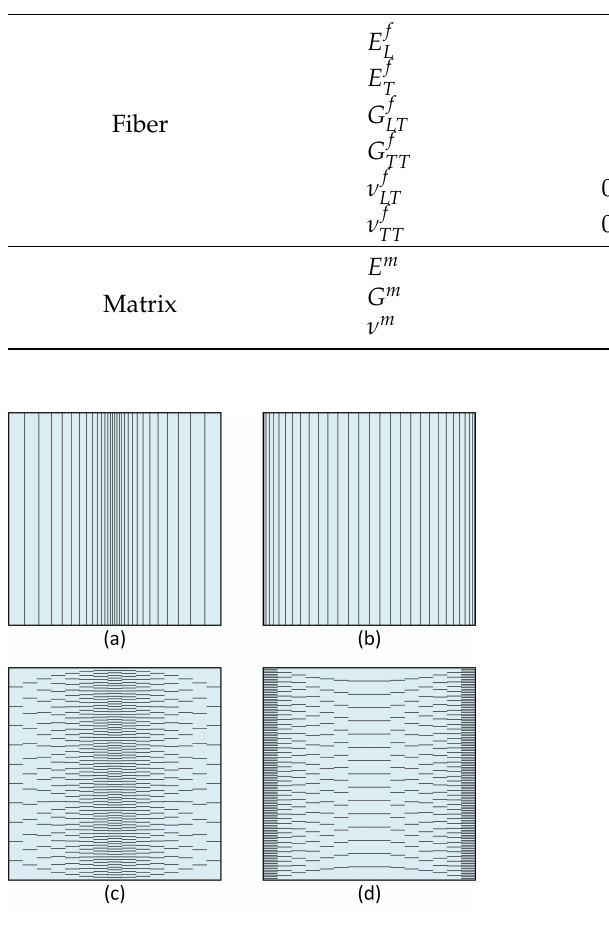
Table 5. Engineering elastic constants of constitutive materials for Example 2.